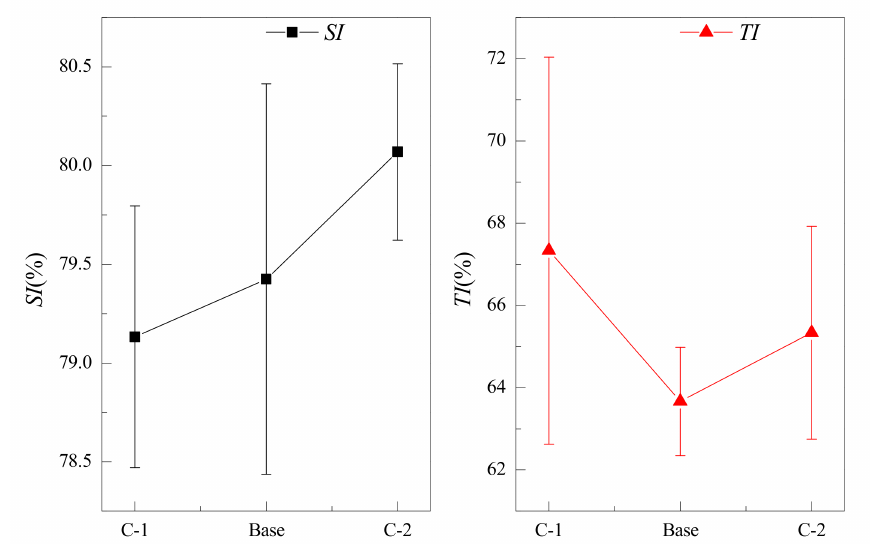
Figure 10. Influences of the water ratio in the sintering mixture on sinter quality. (Water ratios: C-1 = 7; Base = 7.5; C-2 =